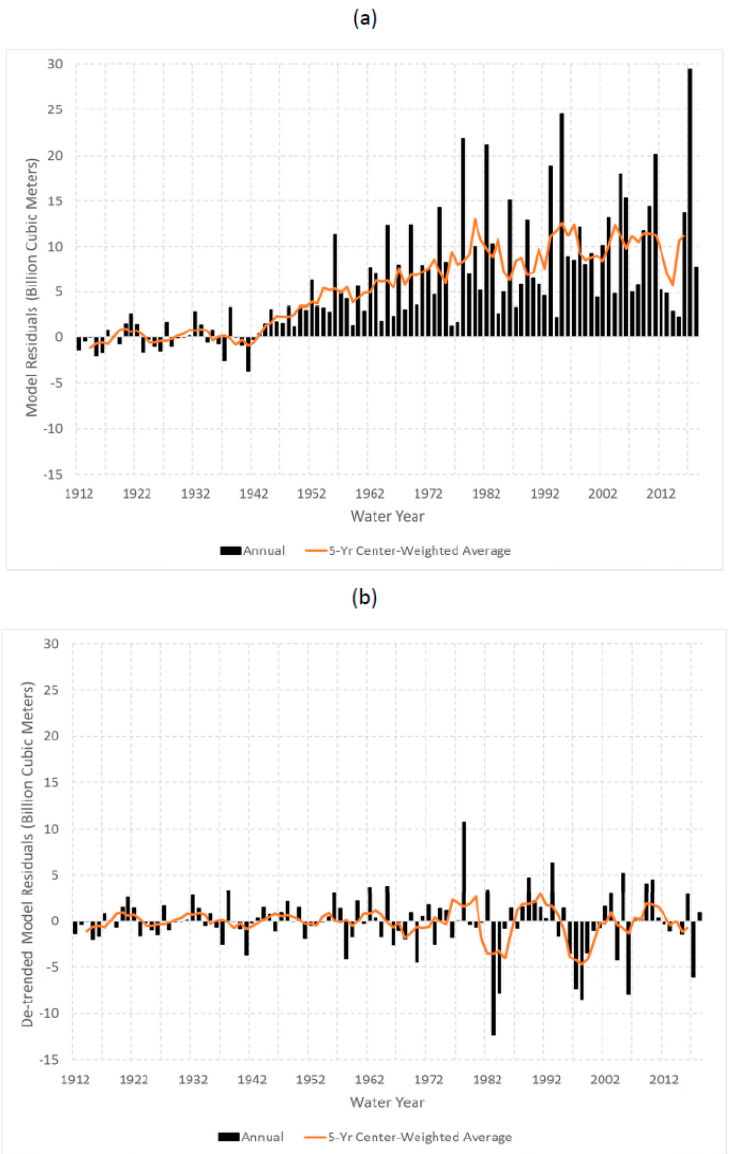
Figure 7. Time series of model residuals associated with contemporary annual runoff–outflow rela- tionship (Model 3). Residuals from Equation (2) applied to the entire WYs 1912–2018 contemporary period are shown in ( a ). De-trended model residuals from Equation (4) applied to WYs 1945–2018 are shown in ( b ).